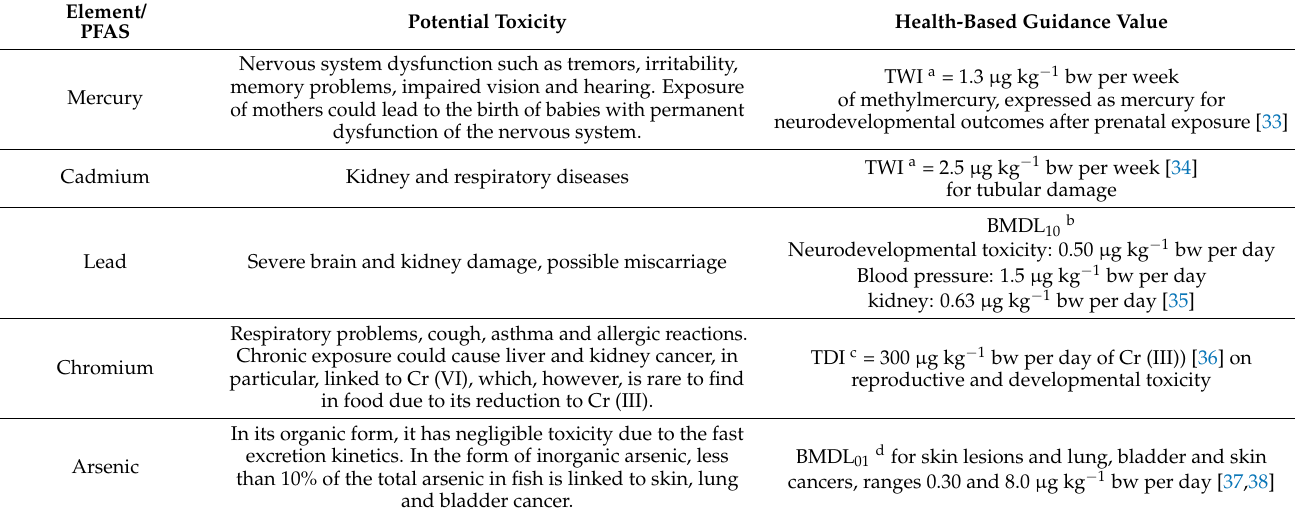
Table 7. Potential toxicity and Health-Based Guidance Values of searched elements and